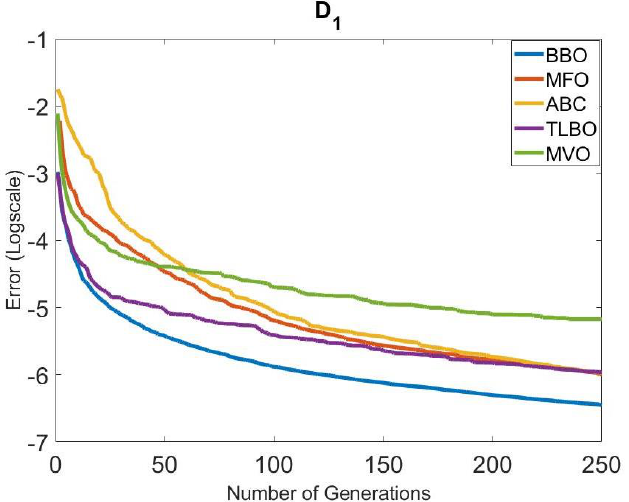
Figure 8. Comparison of the convergence of the metaheuristic algorithms in Group 1 for D 1 .